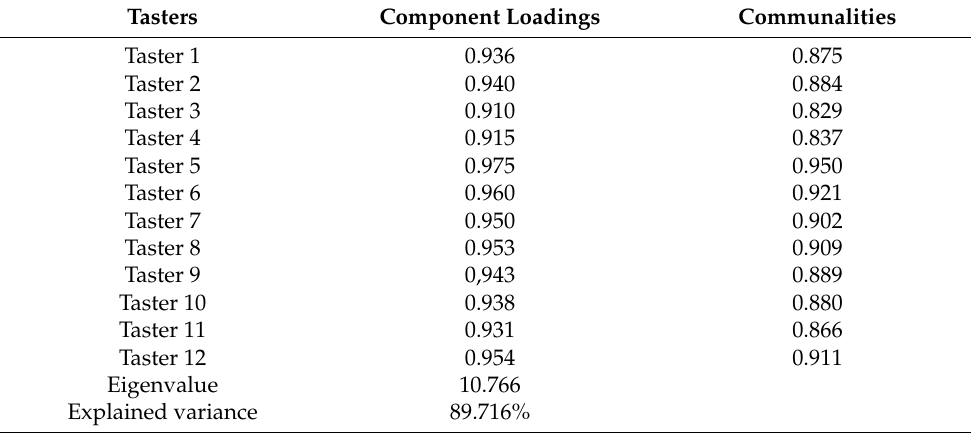
Table 6. Component loadings, communalities, eigenvalue, and explained variance for PP1. Tasters Component Loadings